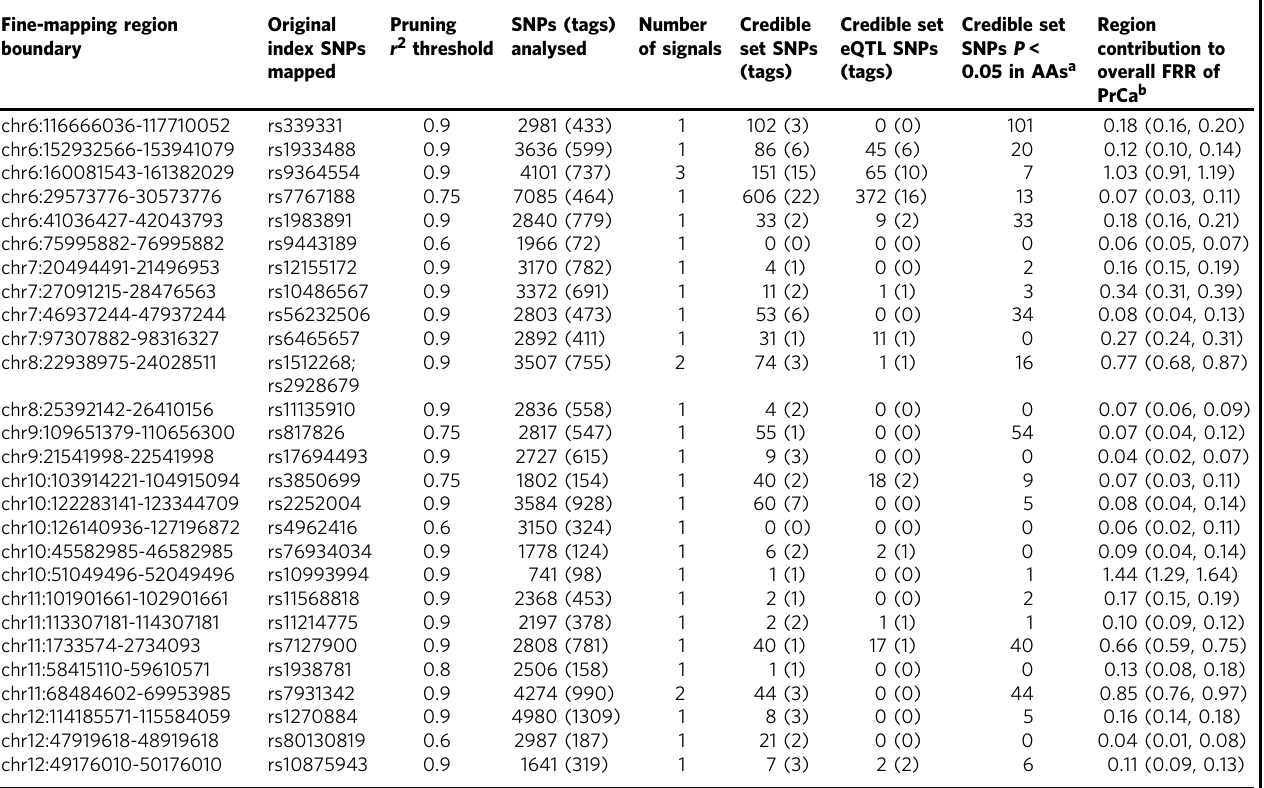
Table 2 Overview of fi ne-mapping results by region for regions 28 – 54 of the 80 regions fi ne-mapped Fine-mapping region